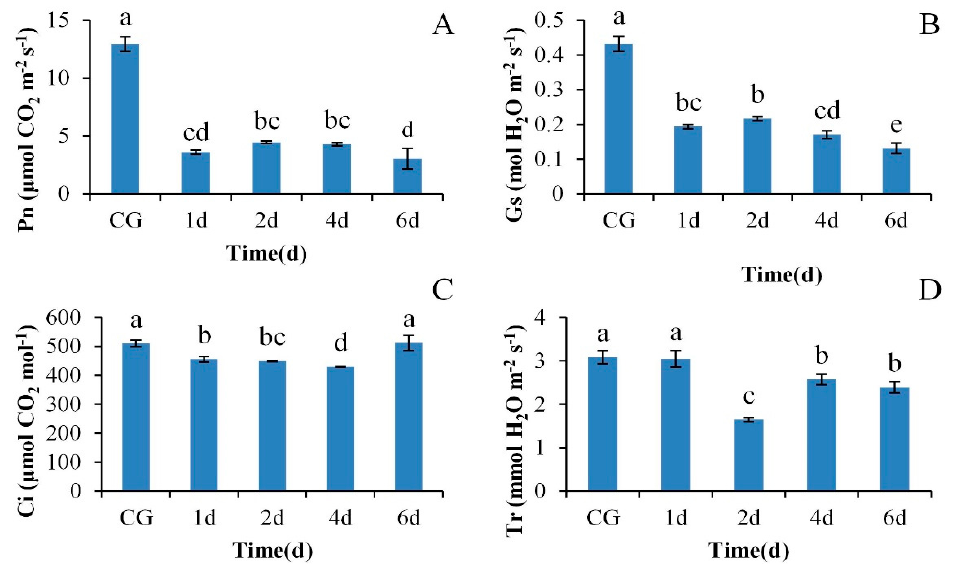
Figure 1. The changes of gas exchange parameters in Pn ( A ), Gs ( B ), Ci ( C ), Tr ( D ) in M. ‘Prairifire’ leaves exposed to 38 ◦ C heat stress. Values are means ± SE ( n = 6). Di ff erent lowercase letters indicate a significant di ff erence at the 0.05 level between di ff erent treatments. CG: Plants were treated with CG conditions; 1d: Plants were treated with 38 ◦ C heat shock for 1 day; 2d: Plants were treated with 38 ◦ C heat shock for 2 days; 4d: Plants were treated with 38 ◦ C heat shock for 4 days; 6d: Plants were treated with 38 ◦ C heat shock for 6 days.